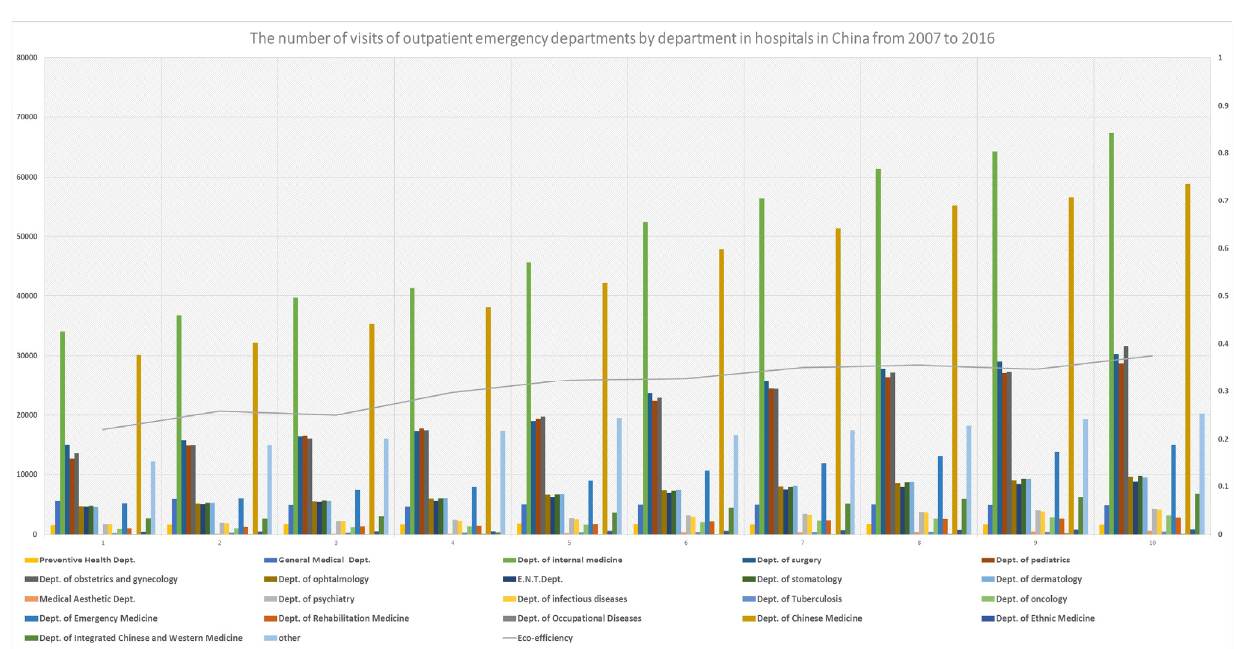
Figure 3. Comparison by department of visits to outpatient emergency departments in China.